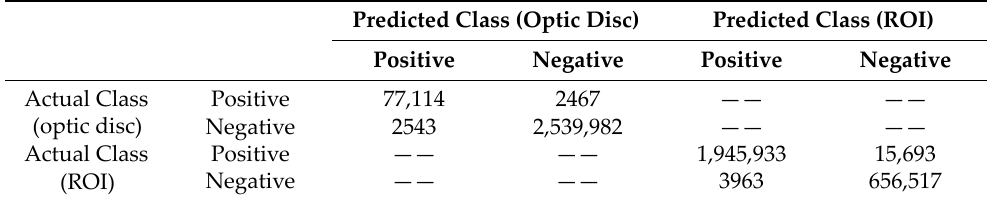
Table 3. The average confusion matrices of optic disc and ROI detection (Unit: